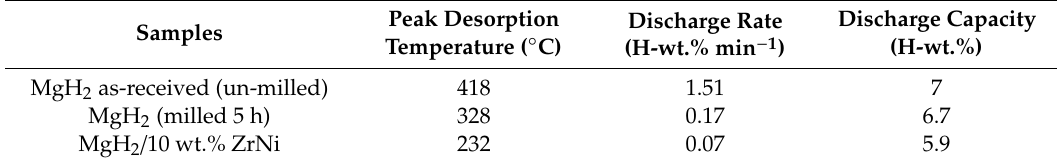
Figure 4. Thermally programmed H 2 desorption capacity curves of studied powders. Same experimental conditions as given in Figure 3. Table 2. Desorption kinetic properties of pure MgH 2 as-received (un-milled), MgH 2 (ball-milled 5 h) and MgH 2 /10 wt.% Zr (x) Ni (y) . The samples were analysed via TPD from room temperature to 500 °C